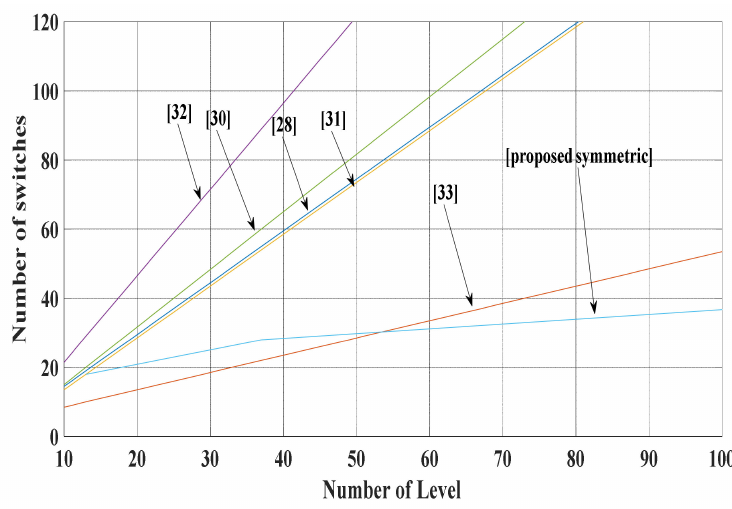
Figure 11. Variation in number of switches with number of leVels.